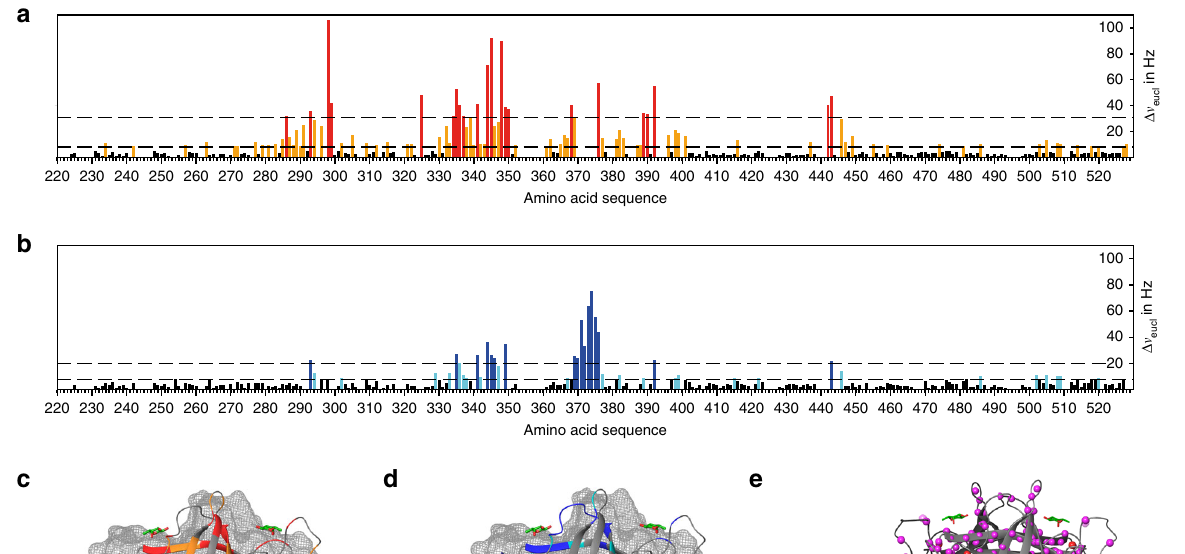
standard 41 . Data were denoised using singular value decom- position (SVD) as described before 19 , and CSPs were calculated as Euclidean distances. As the resulting curves exhibited visibly different shapes the data were subjected to complete linkage